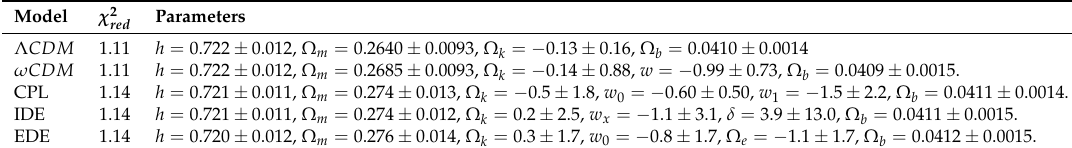
Table 7. The best fit values for the free parameters using data from GC ( d A + f gas ).